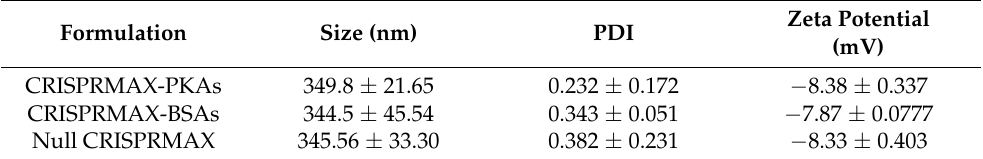
Table 1. Size, polydispersity index (PDI), and zeta potential of optimized CRISPRMAX-PKAs, CRISPRMAX-BSAs, and control null CRISPRMAX. There was no significant difference in particle size compared with control null NPs ( p = 0.88895, p = 0.38939, respectively). Zeta potentials were all around 8 mV negative charge, with no significant difference in the surface charge compared with control null NPs ( p = 0.12596, p = 0.83723, respectively). Values were expressed as mean ± SD, n =